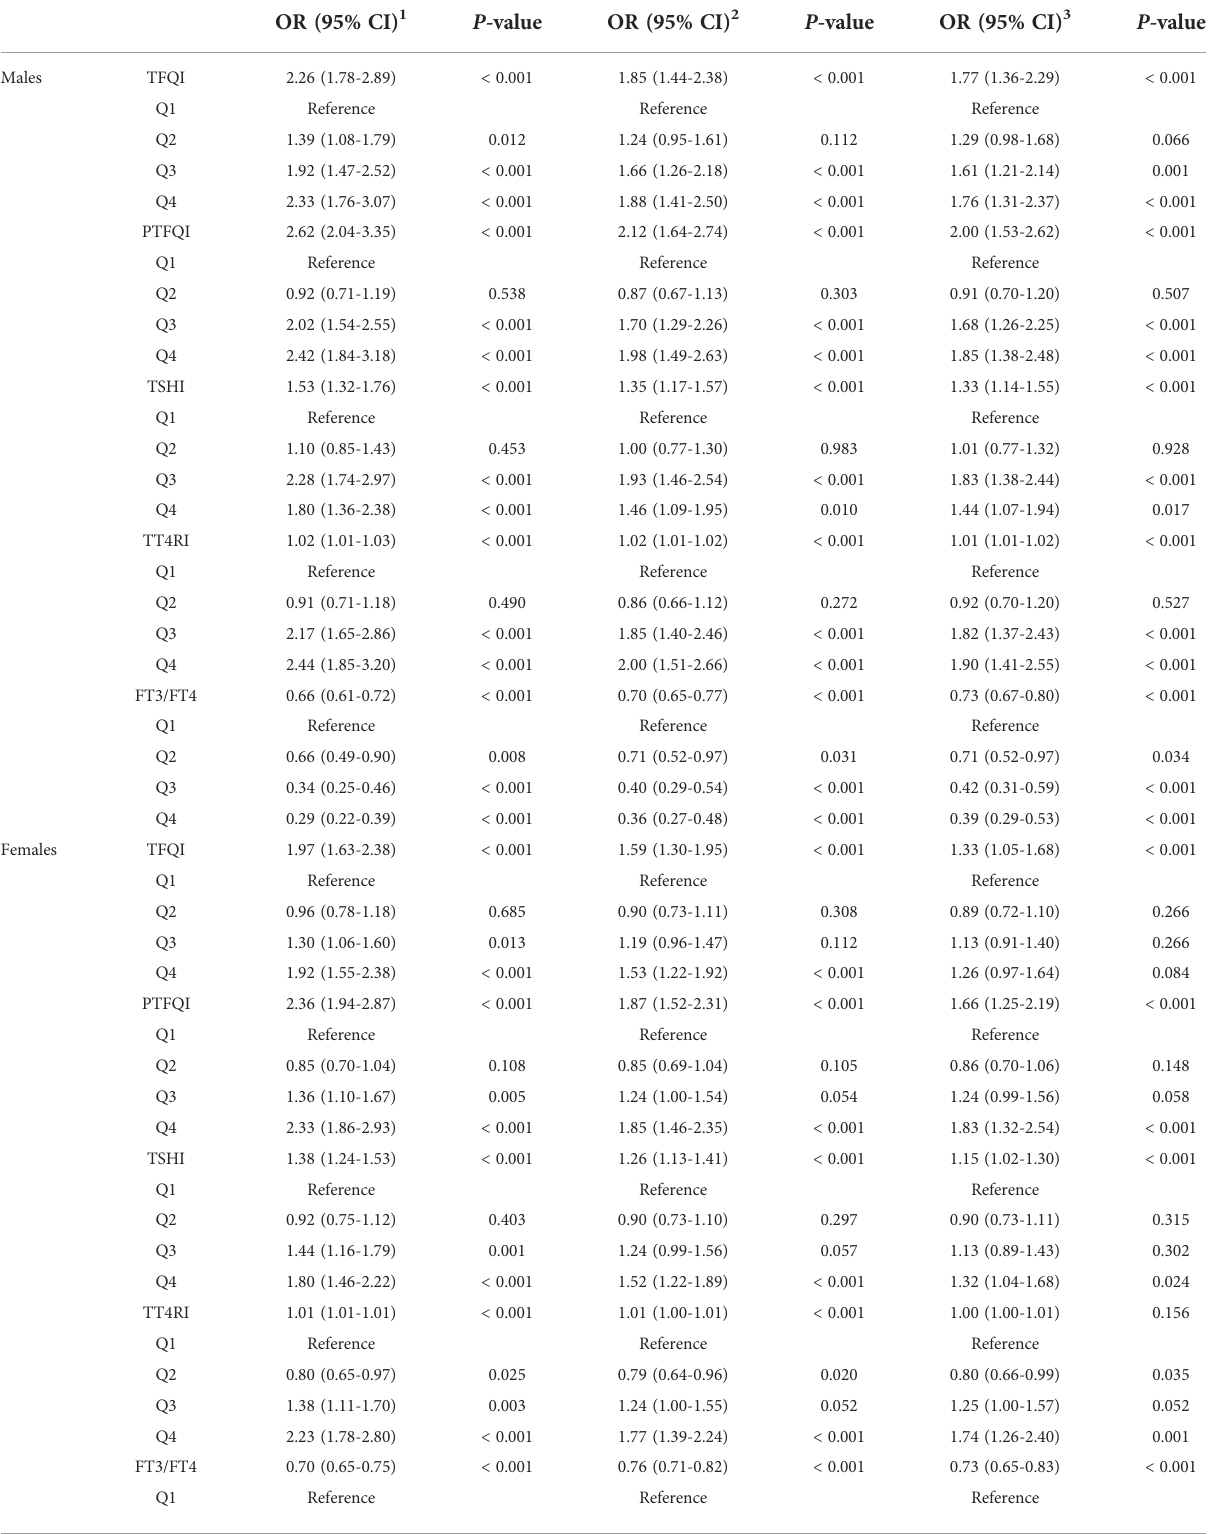
TABLE 3 Association between thyroid hormone sensitivity and carotid plaque according to sex.